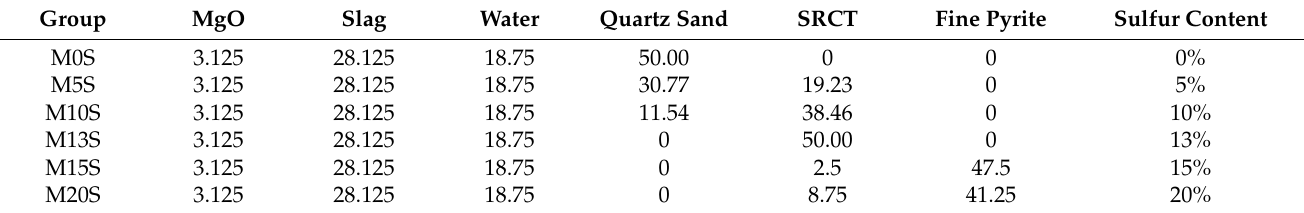
Table 2. Mix proportions of MASMs (g/100